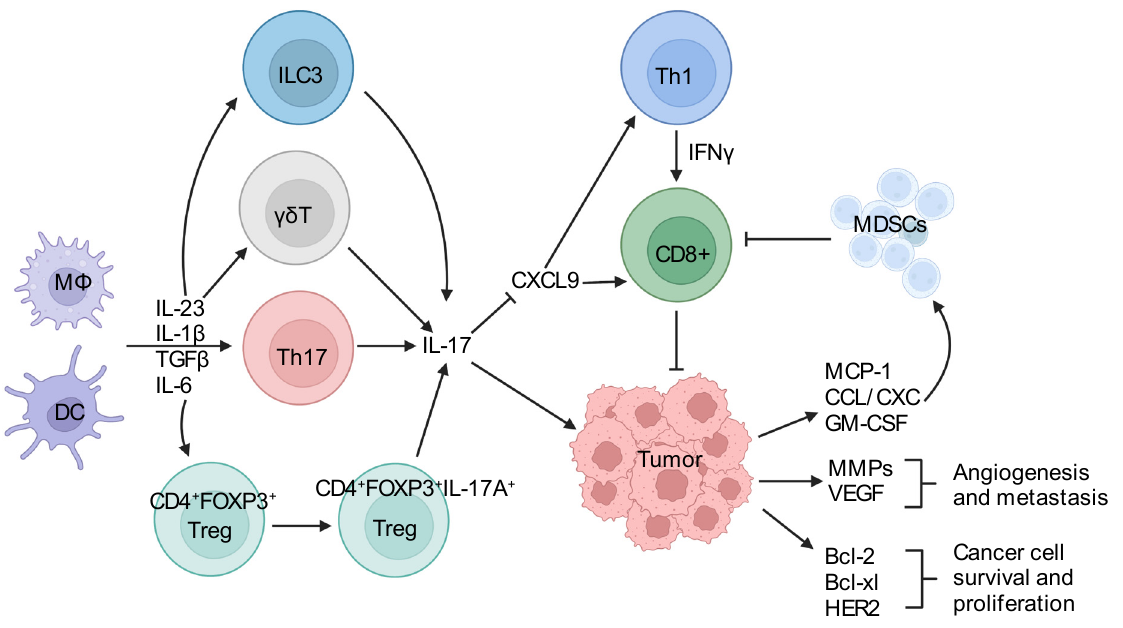
Figure 1. How IL-17 promotes cancer development.